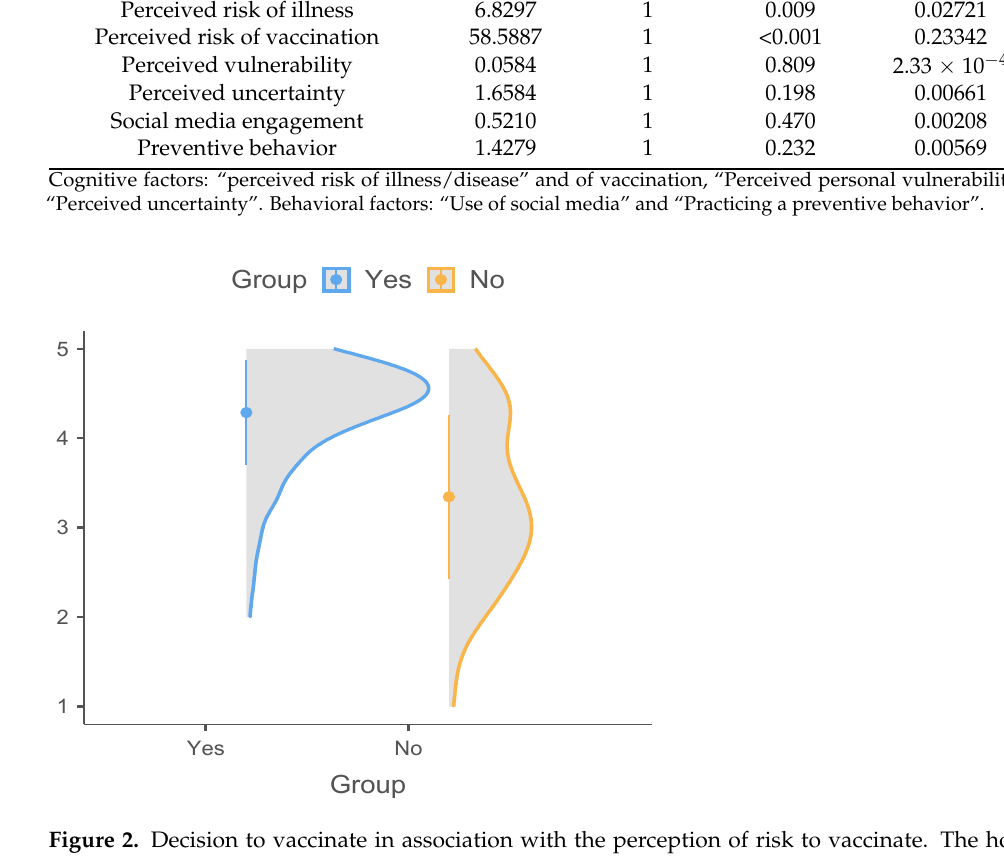
Figure 2. Decision to vaccinate in association with the perception of risk to vaccinate. The horizontal axis: groups of vaccinated/not vaccinated; the vertical axis: risk perception on vaccination; Higher numbers correspond to lower risk (e.g., 5 means lowest perceived risk and 1 means highest perceived risk). Table 4. Equivalence test and effect